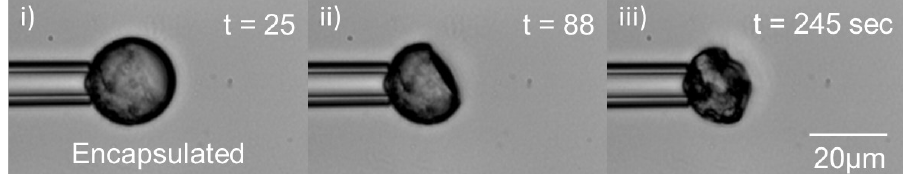
Figure 9. Evidence for Phase of Ibp separation at very high Ibp concentrations. Images of Ibp/PLGA (50:50) microsphere at DL = 80 wt%. (i) 25 s after formation of the droplet the microparticle formed in which all the DCM had been dissolved into aqueous phase; (ii) at t = 88 s, a large part of the microparticle had dissolved; (iii) at 245 s other parts of the microparticle were lost and the microparticle became deformed This loss of material appeared to be dissolution of large domains of Ibp that were not seen for DL = 60 wt% and below, signifying massive phase separation into Ibp rich domains.